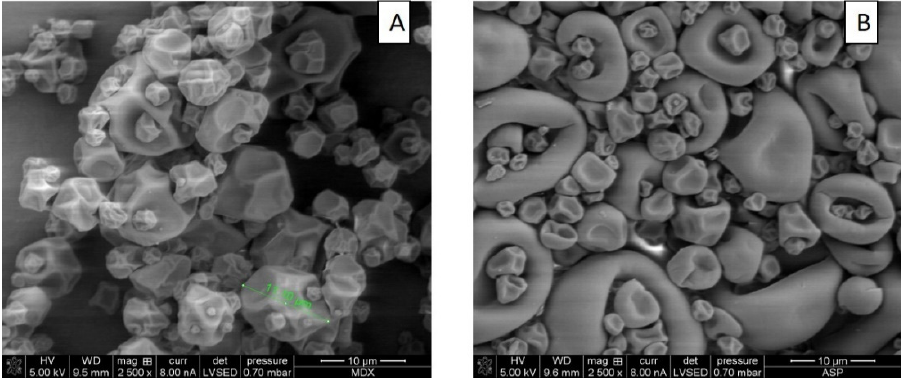
Figure 3 . Micrographs obtained by scanning electron microscopy of the muicle extract spray-dried microcapsules with MD ( A ) and SPI ( B ) obtained under optimal conditions.